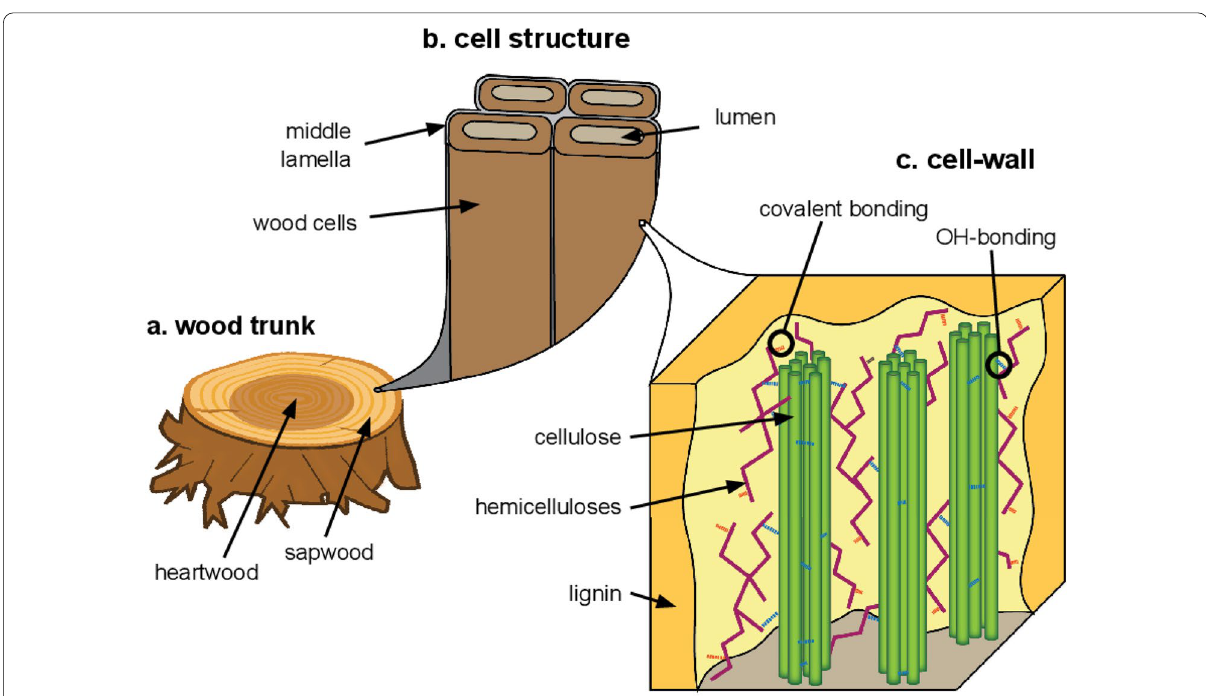
Fig. 2 Cellular structure and timber constituents